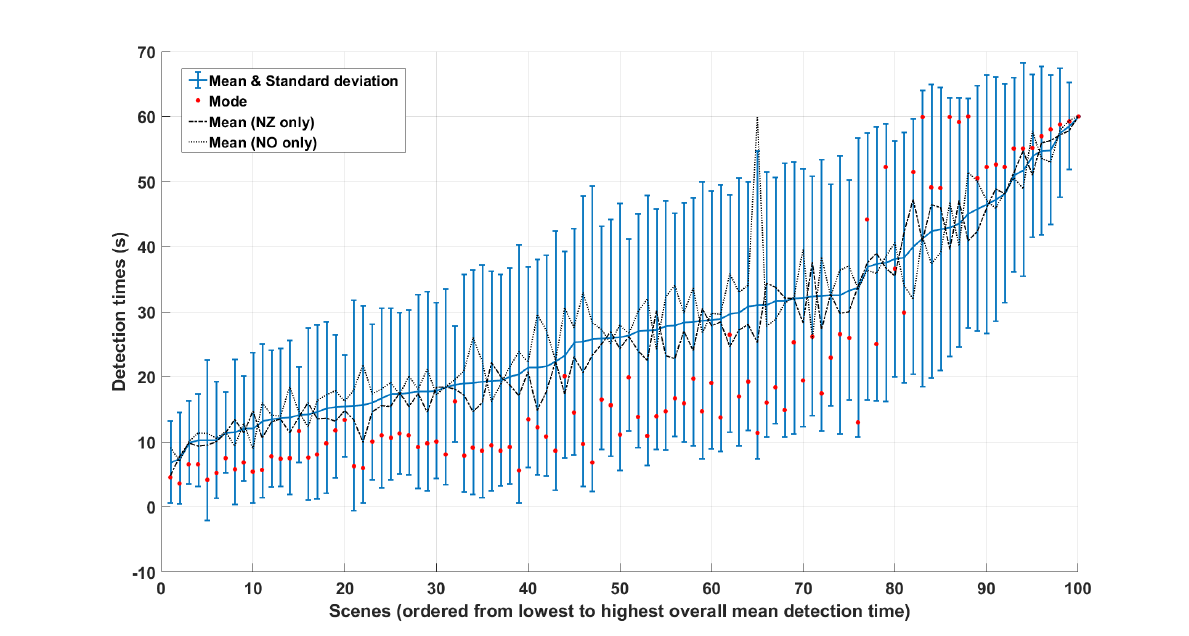
Figure 3. Average (blue line), mode (red dots) and standard deviations (bars) of individual T o , i . Notice that, when projecting all the red dots on the y -axis, there are two distinct clusters of scenes separated by a region of low density around 35 s. Dotted lines represent the average for the New Zealand and Norway-based